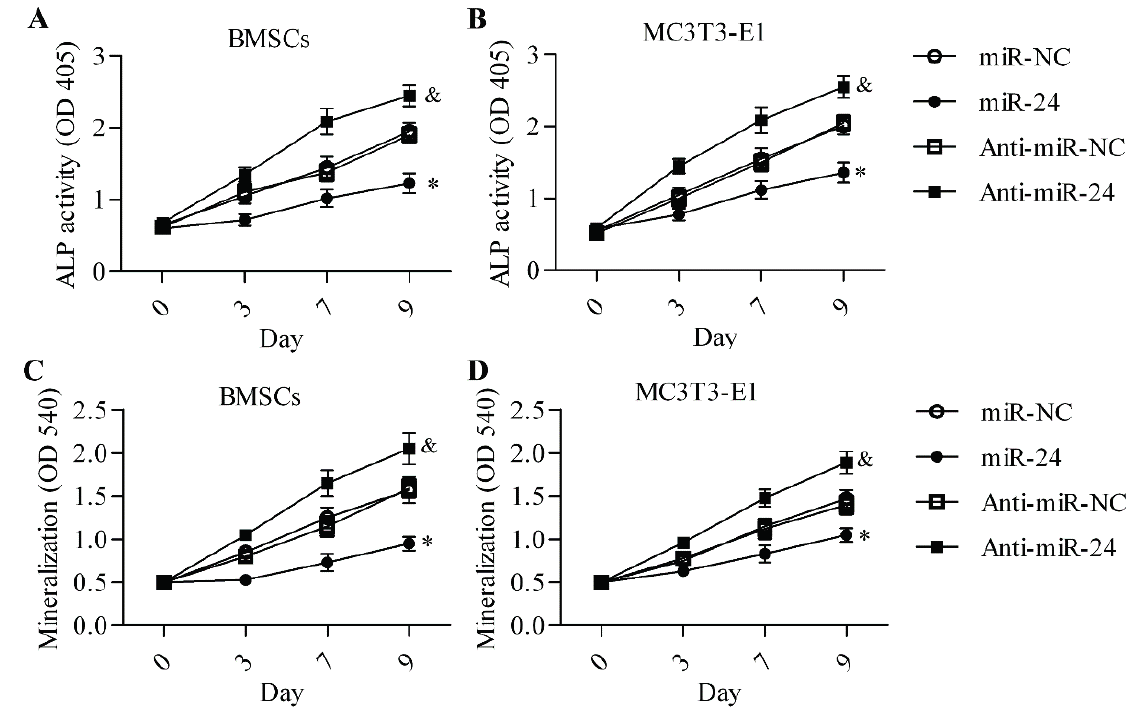
Figure 2. Effect of miR-24 gain or loss on osteogenic differentiation. ALP activity was detected in BMSCs ( A ) and MC3T3-E1cells ( B ) using a commercial ALP activity assay kit. Cells were transfected with miR-24 or anti-miR-24 (day 0) for 48 h and then cultured in differentiation medium for the induction of osteogenic differentiation. The absorbance at 405 nm was measured at days 3, 7 and 9; Mineralization in BMSCs ( C ) and MC3T3-E1cells ( D ) was assessed using Alizarin red S staining. The absorbance at 540 nm was quantified. N = 6, * p < 0.05 vs. miR-NC; & p < 0.05 vs. anti-miR-NC. 2.2. Inhibition of miR-24 Elevates the Expression of Osteogenic Differentiation Markers ALP, collagen type I α 1 (ColA1), and osteopontin (OPN) have been suggested as the molecular markers of osteogenic differentiation [27]. The expression of all these genes was significantly downregulated with miR-24 overexpression, whereas inhibition of miR-24 markedly elevated the expression of all these genes (Figure 3A–C). Furthermore, the key osteogenic transcription factor Runx2 was also remarkably downregulated by miR-24 overexpression or upregulated by miR-24 inhibition (Figure